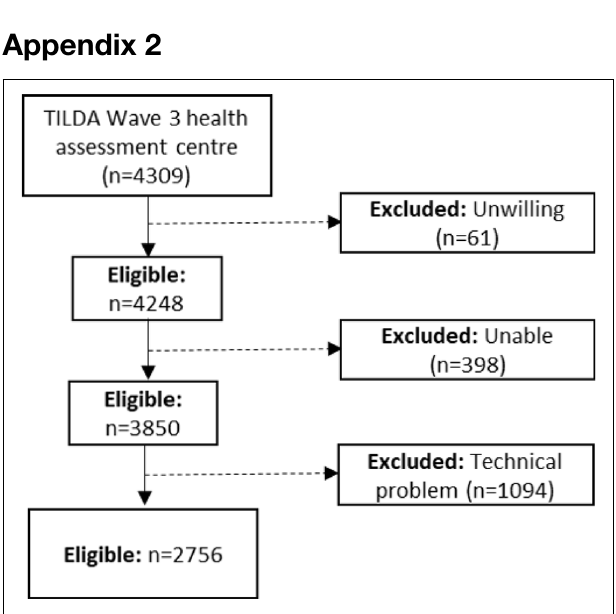
FIGURE 7 | Exclusions for cerebral oxygenation